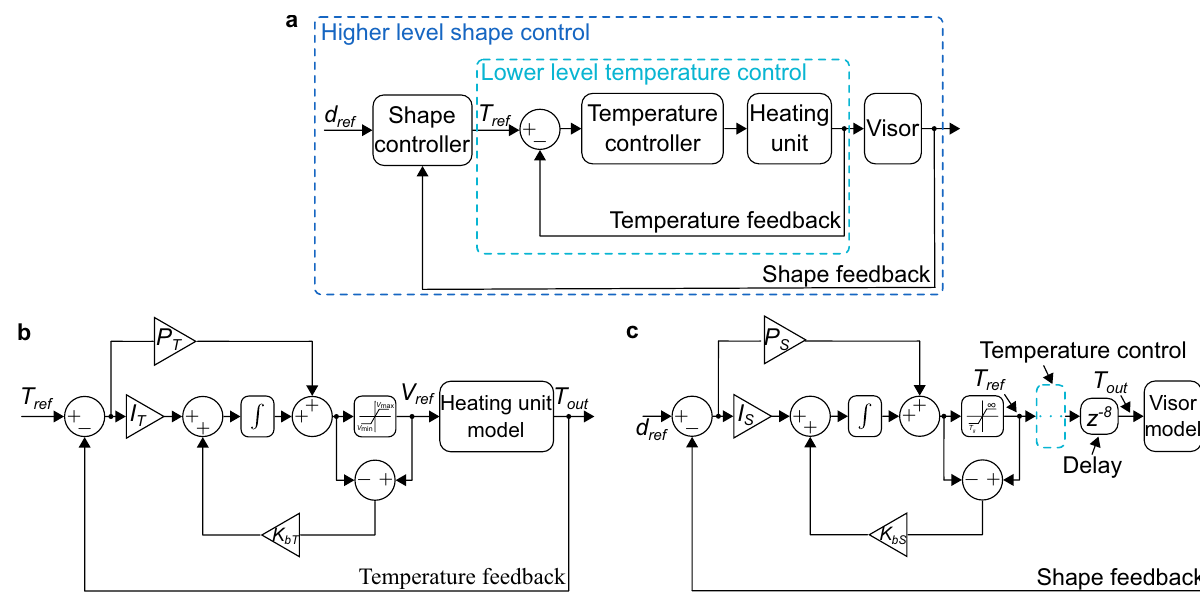
Figure 5. Control structure. ( a ) Cascade control structure. ( b ) Lower level temperature control. ( c ) Higher level shape